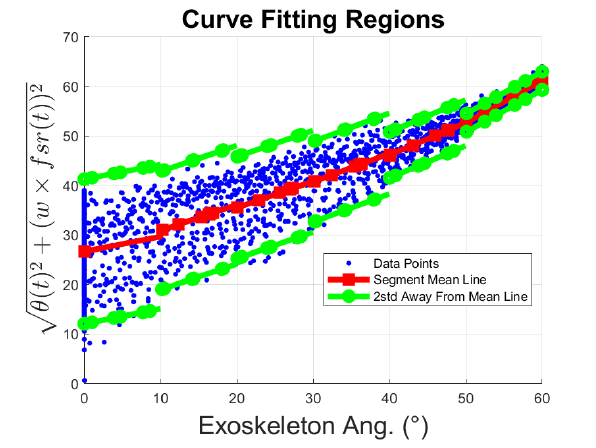
Figure 11. 1st-order polynomial curve fitting by